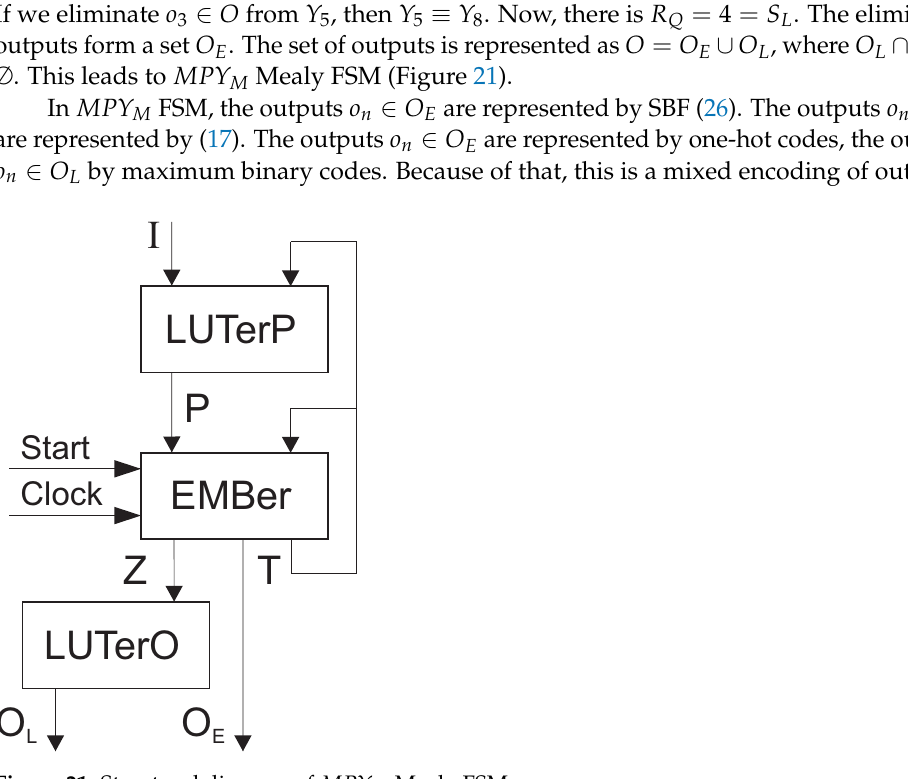
Figure 21. Structural diagram of MPY M Mealy